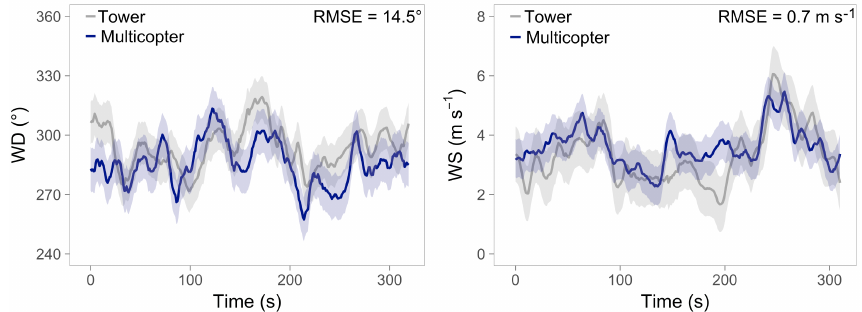
Figure 5. Wind direction (WD) and speed (WS) comparison between tower (grey) and multicopter (blue) at 9ma.g.l. over 5min. The colored bands around the lines represent the standard deviation of each time